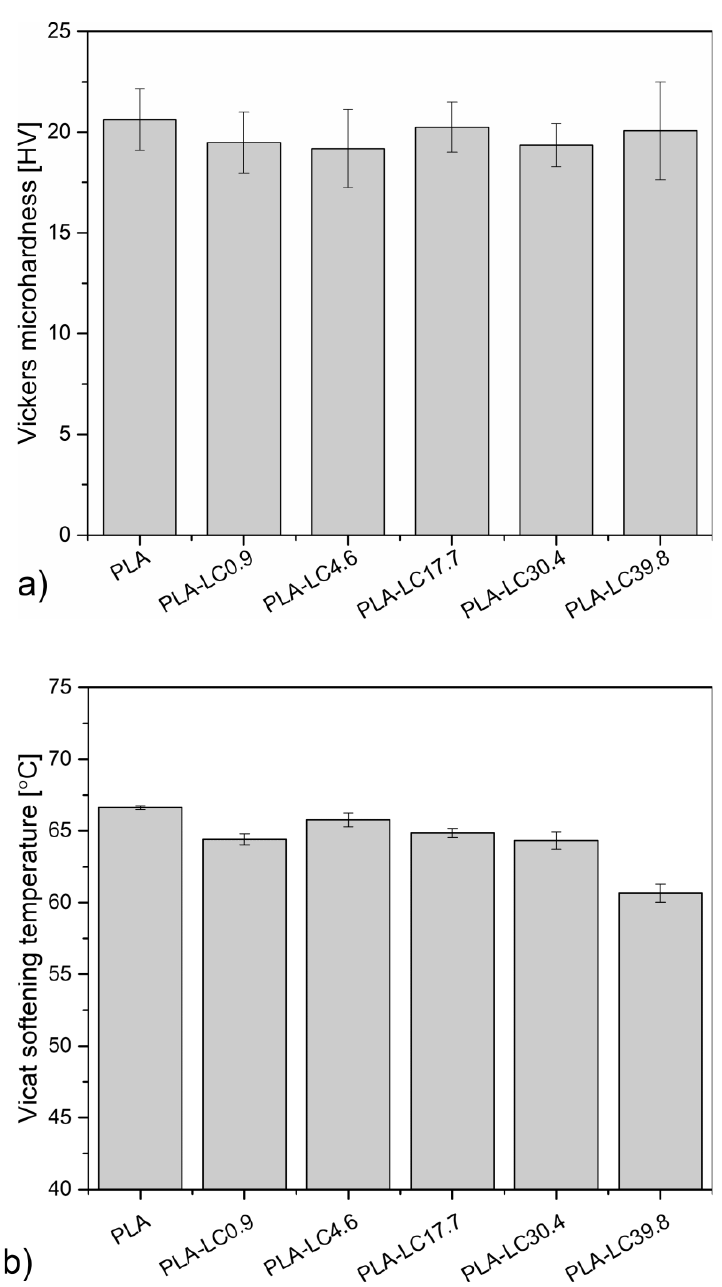
Figure 2. Vickers microhardness ( a ) and Vicat softening temperature ( b ) of PLA and its